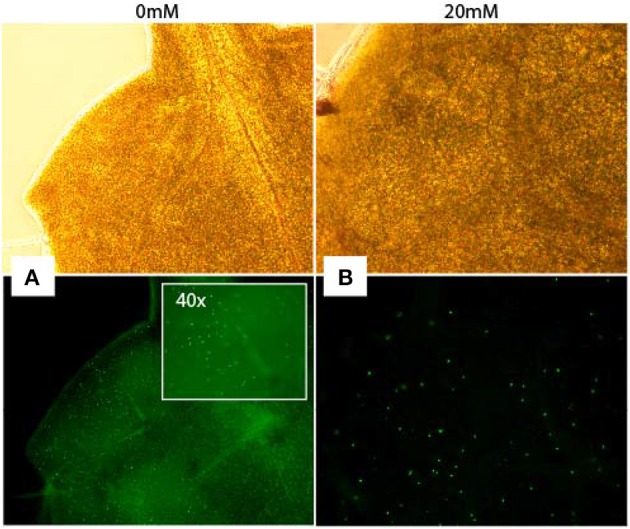
Analysis of DNA synthesis in A. thaliana. Newly synthesized DNA of a mock-treated seedling (A) and a seedling subjected to 20 mM AITC for 36 h (B) visualized by EdU-staining of tissue for 4 h after treatments. Pictures were captured under light (top pictures) and fluorescence (bottom).